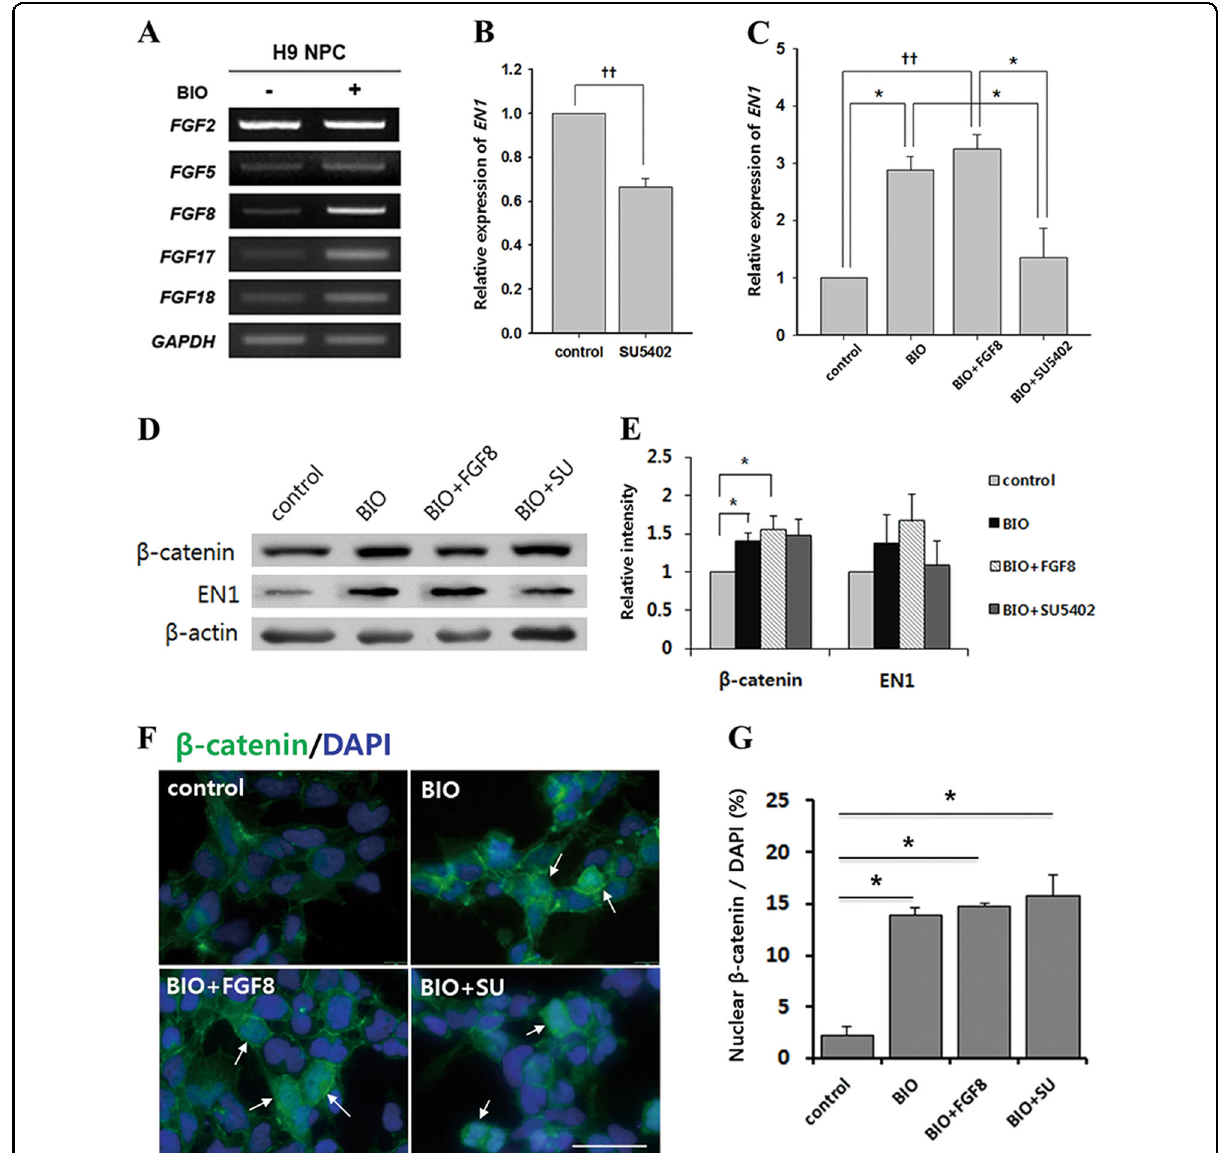
Fig. 3 FGF signal is required for induction of EN1 by activation of Wnt signal. a Semi-qRT-PCR analysis showed endogenous and BIO-induced expression of various FGFs in human ESC-derived NPCs. b Inhibition of endogenous FGF signals by SU5402 signi fi cantly decreased basal EN1 expression. c Co-treatment with BIO and FGF8 slightly increased EN1 expression more than BIO alone whereas co-treatment of SU5402 with BIO abrogated the upregulation of EN1 expression ( n = 4). d , e Immunoblotting corresponded with the EN1 expression in qRT-PCR ( n = 3). f , g Nucleus localization of β -catenin was induced by Wnt activation, but not affected by FGF. White arrows indicate β -catenin in nucleus (scale bar: 20 μ m, n = 3). Statistical signi fi cance was examined by one-way ANOVA; †† p = 0.001, * p <